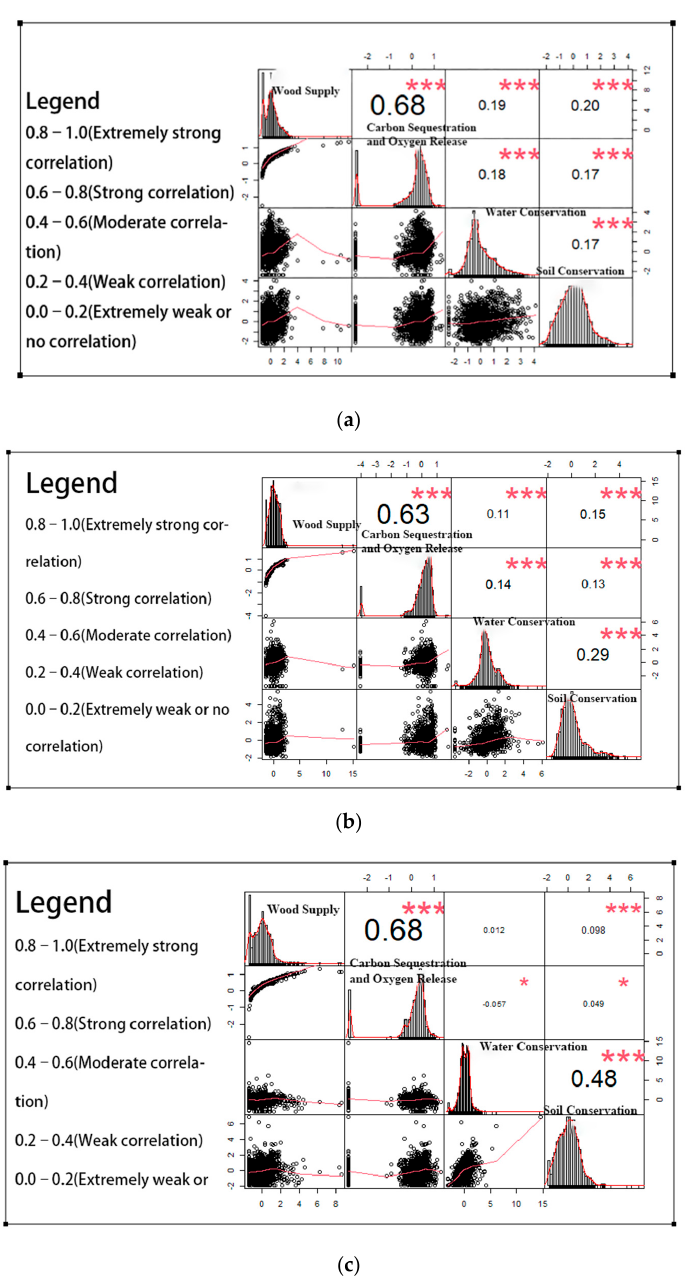
Figure 3. A scatter plot matrix was used to show the results of the ES correlation analysis of PM plantation forests in Guangxi Paiyangshan Forest Farm from 2009 to 2018. Pearson correlation coefficients range from − 1 to 1, indicating negative and positive correlations, respectively. The strength of correlation increases as the absolute value of the Pearson correlation coefficient approaches 1. Statistical significance is indicated by asterisks, with * representing significance at the 0.05 level, and *** at the 0.001 level. The scatterplot matrices for 2009, 2013, and 2018 are presented as ( a ), ( b ), and ( c ),